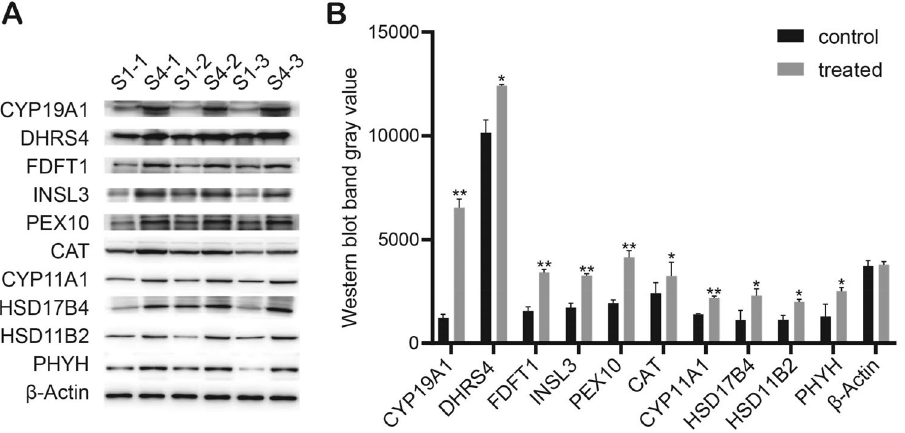
Figure 8. Validation of ten selected proteins in testicular tissue of animals from treatments S1 and S4 by Western blotting. ( A ) The abundance of CYP11A1, CYP19A1, HSD11B2, FDFT1, PEX10, PHYH, HSD17B4, CAT, DHRS4 and INSL3 proteins were analyzed by Western blotting in three replicates. The β-actin was used as an internal reference. ( B ) Comparison and verification of the quantitative results for selected proteins from the Western blotting. The values shown are the means ± SEM (Significant difference: * P < 0.05; ** P < 0.01; *** P < 0.001). S1: control diet; S4: control diet supplemented with 4 μg/kg 1α,25(OH) 2 VD 3. 1α,25(OH) 2 VD 3 was provided as 1α,25(OH) 2 VD 3 -glycosides from plant origin (n = 3 per